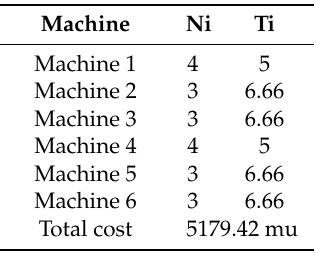
Table 2. Case 1: Maintenance plan for individual maintenance policy.